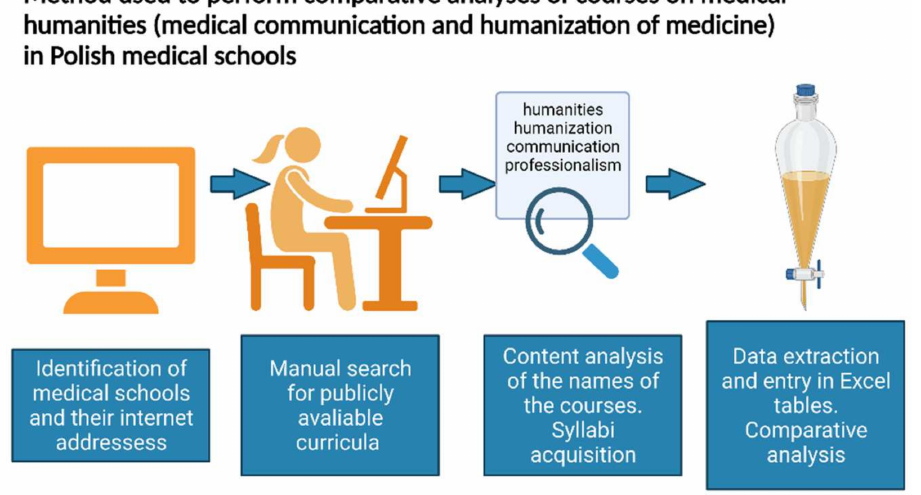
Figure 1. The methodological approach used in the study. Created with